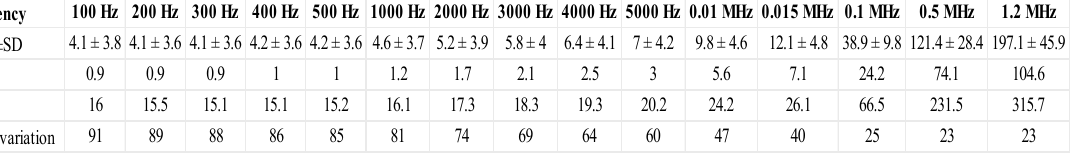
Figure 4. Correlation between conductance readings for the tested oil samples and test voltage frequency, including base data for the results.